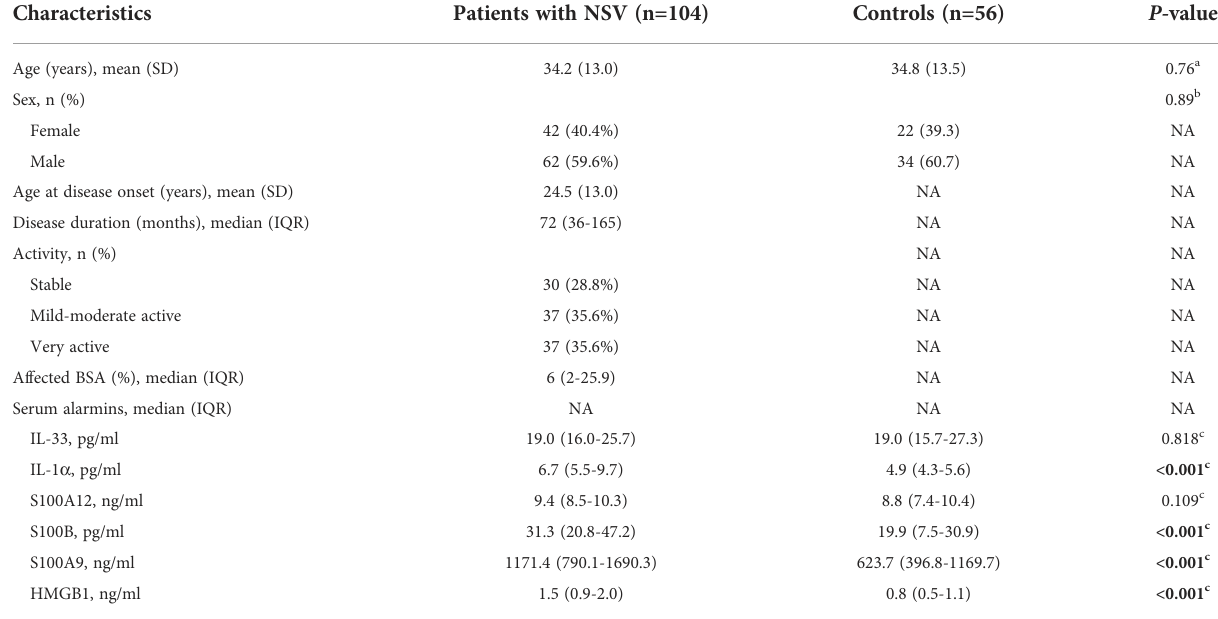
TABLE 1 Baseline demographics and clinical characteristics.